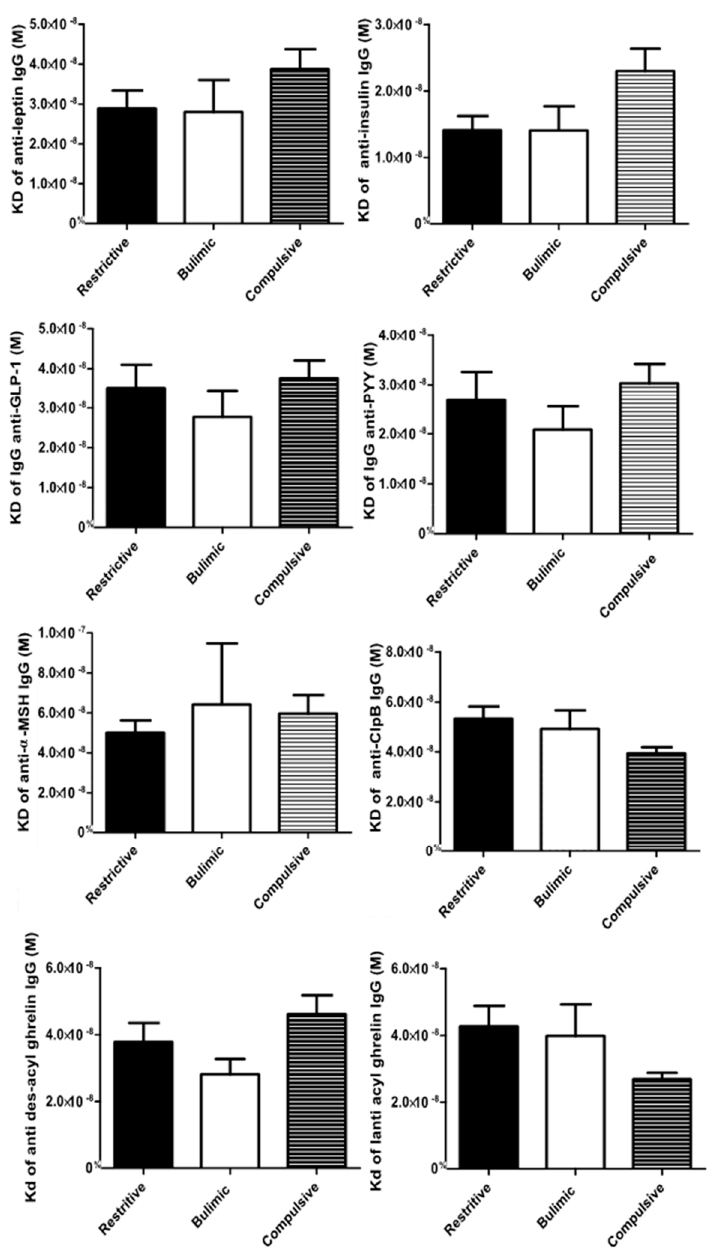
Figure 3. Affinity of plasma IgG against peptides associated with food intake according to broad categories of ED. The standard deviation is represented by the error bar.